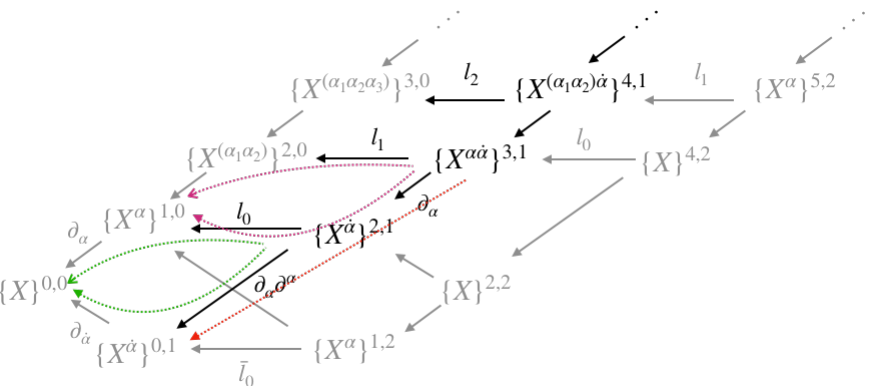
Figure 4. { X ( α 1 α 2 ··· α n − 2 ) ˙ α } n, 1 ( n ≥ 2) represents the second branch and each term corrects two spaces as can be read from the diagram. The green loop represents the first example, while the purple loop and red straight line illustrate the second example, as explained in the text. The maps l n are given in the